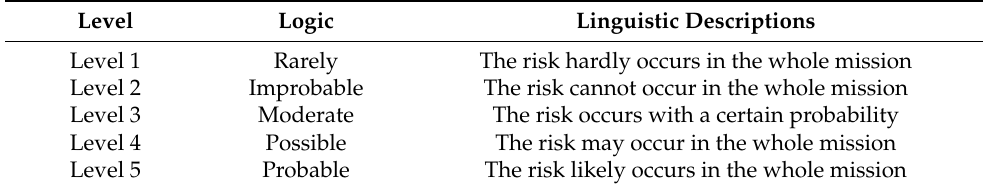
Table 2. Evaluation criterion of occurrence likelihood.